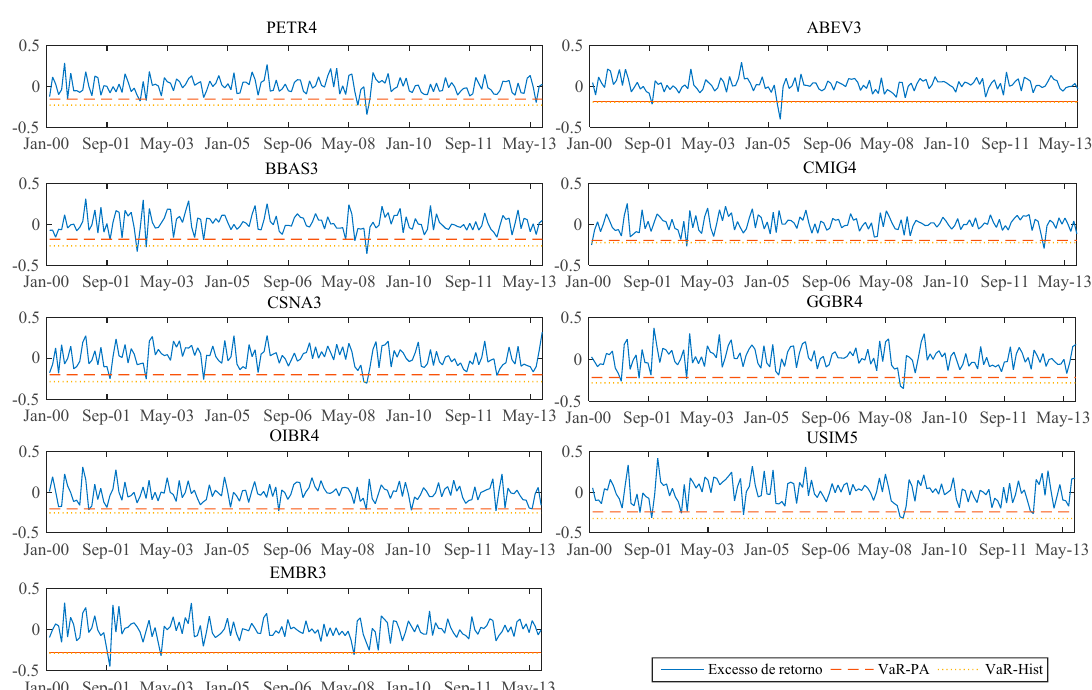
Figure A6. Random walk models VaR versus historical VaR.